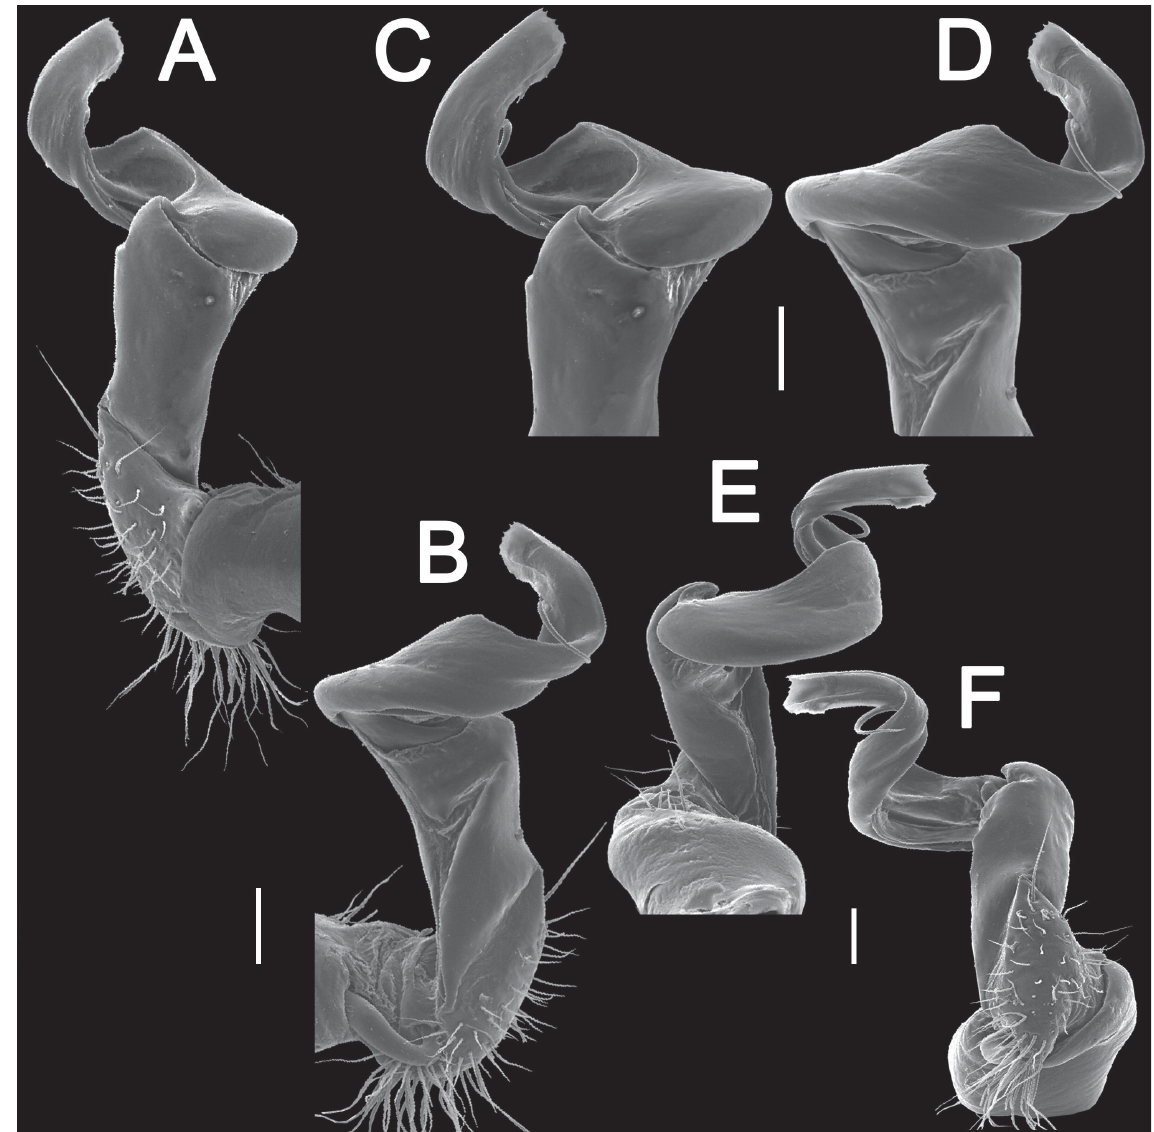
Fig. 9. Tylopus moniliformis sp. nov., holotype, ♂, left gonopod. A–B . Lateral and mesal views, respectively. C–F . Distal part, lateral, mesal, subcaudal and suboral views, respectively. Scale bars = 0.1